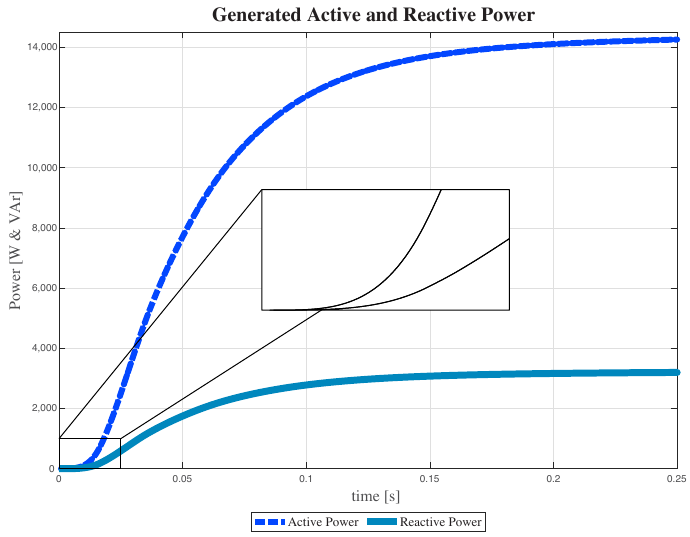
Figure 12. Active and reactive power from the inverter is delivered to the stand-alone